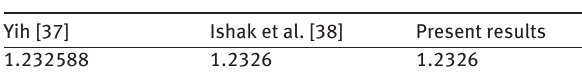
Table 1: Comparison of results for f (cid:2)(cid:2) (0) when Λ = 1, M = K = A = 0 .